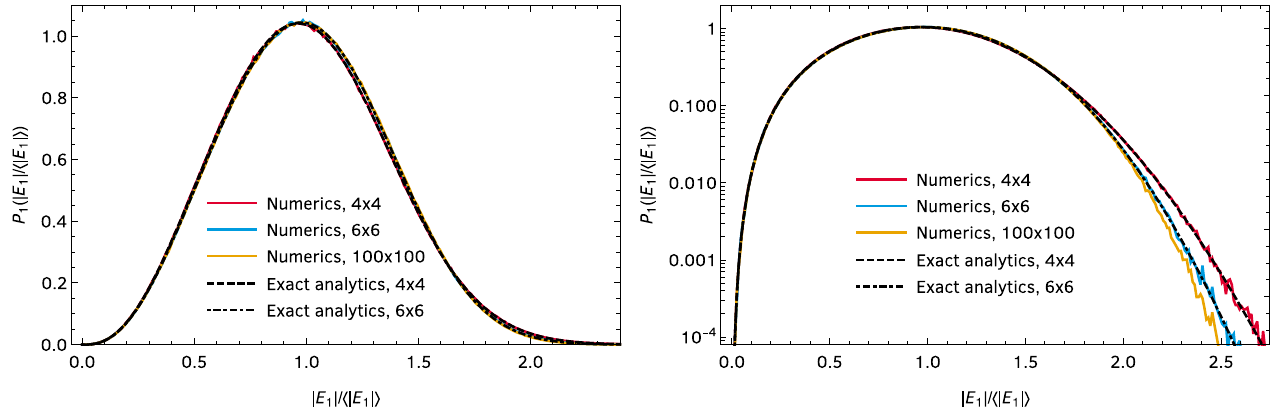
FIG. 14. Distribution of the eigenvalues with smallest absolute values, P 1 ðj E 1 j = hj E 1 jiÞ , for random matrices from class AIII † , on linear (left panel) and logarithmic (right panel) scales. The solid, colored curves are obtained from the exact diagonalization of 10 7 random matrices of different sizes, while the dashed and dot-dashed black lines are the exact analytic results for D ¼ 2 [ 4 × 4 matrices, Eq. (25)] and D ¼ 3 ( 6 × 6 matrices).